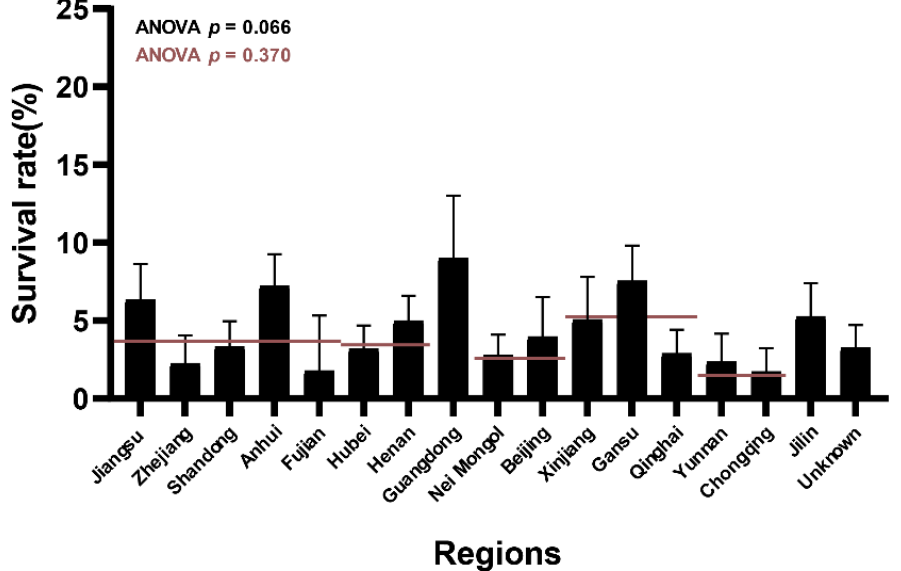
Figure 1. Average survival rates of L. salivarius strains isolated from different regions. The red line represents the average survival rates of the strains in different China part-groups. One-way ANOVA analysis was applied to compare the differences in survival rates in each region-group ( p -values in black) and each China part-group ( p -values in red).